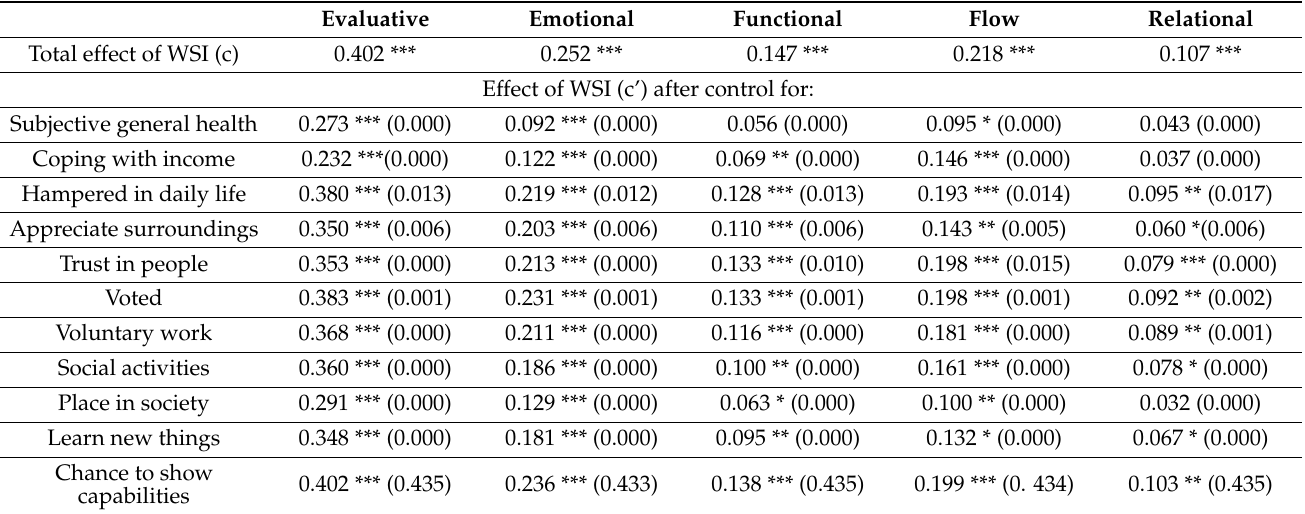
Table 3. Coefficient for WSI without (top row) and with control for intervening variable